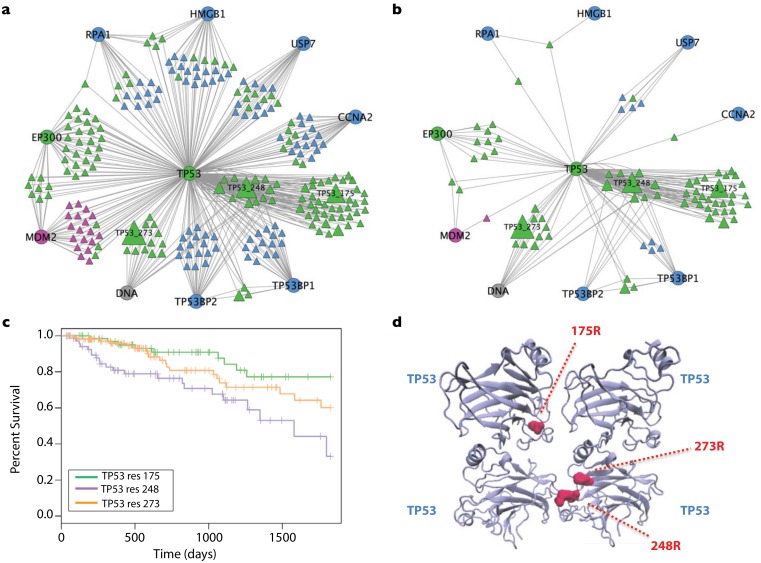
Mutations affecting TP53 interaction interfaces and their impact on patient survival.a) A bipartite network of the tumor suppressor TP53, its partners and the interface residues by which they interact. b) A bipartite network showing only the subset of residues observed to harbor missense mutations in cancer patients. The size here of the residue nodes represent the number of tumors in which the residue was mutated. c) A Kaplan Meier survival plot of patients from TCGA harboring mutations in TP53 at residues 175, 248 or 273. d) The TP53 mutations R175, R273 and R248 displayed on the crystal structure of TP53 as a homotetramer.